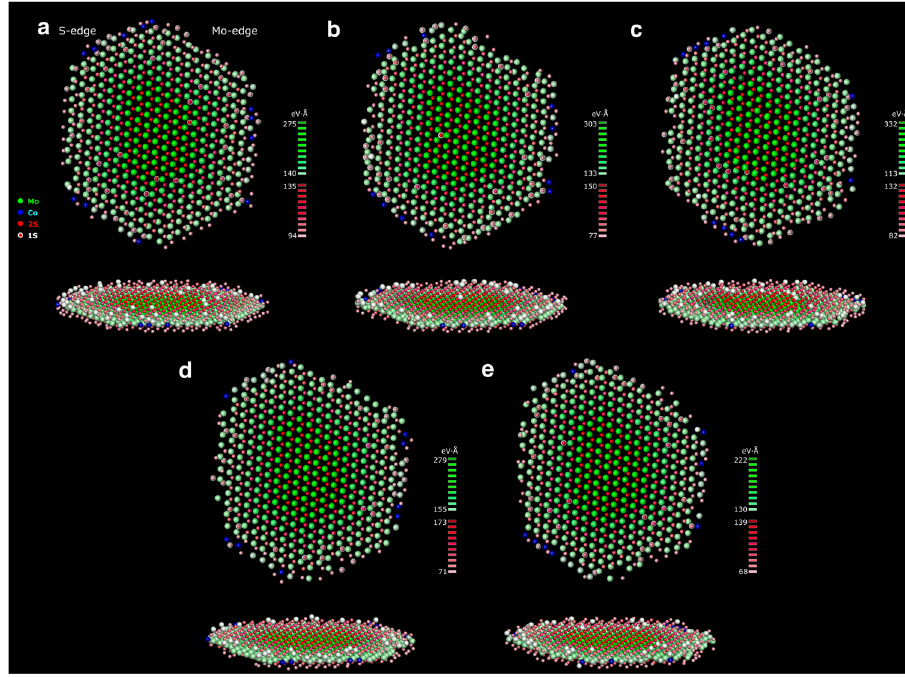
Fig. 3 3D atom-dynamic maps of the Co-Mo-S nanocrystal. a – e The time-series of reconstructed 3D atomic-resolution images generated for the successive exit waves shown in the Supplementary Fig. 2. The 3D images depict the atoms with a color re fl ecting the stoichiometry of each atomic column and a color modulation in accordance with the V ’ values (Fig. 1d). Speci fi cally, 1Mo is denoted by green dots, 1Co by blue dots, 2S columns by red dots, 1S columns by red dots over white dots and S vacancies by white dots. The corresponding exit waves are obtained from image acquisitions commencing at 153 s, 378 s, 423 s, 574 s, and 624s, relative to time t = 0 s when the electron beam was switched on (Supplementary Fig.